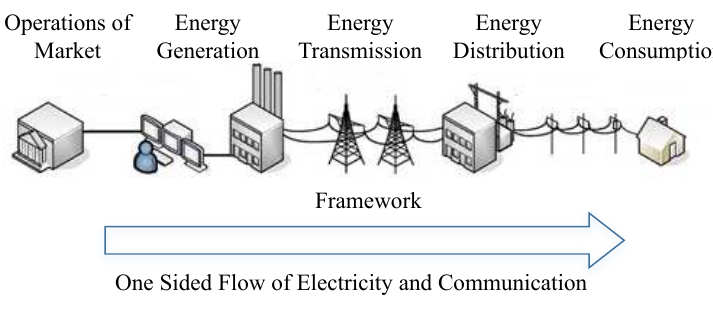
Figure 1. Traditional Grid.